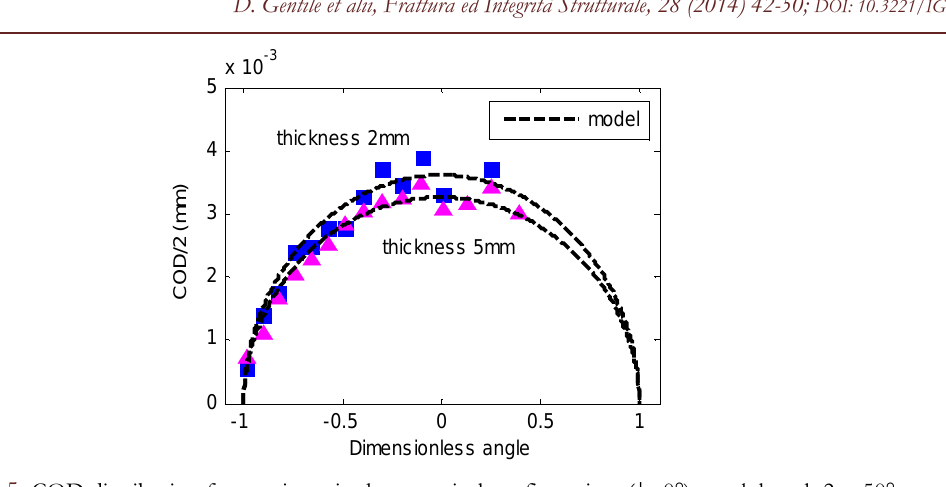
Figure 5: COD distribution for specimen in the canonical configuration, (  =0°), crack length 2  50°.